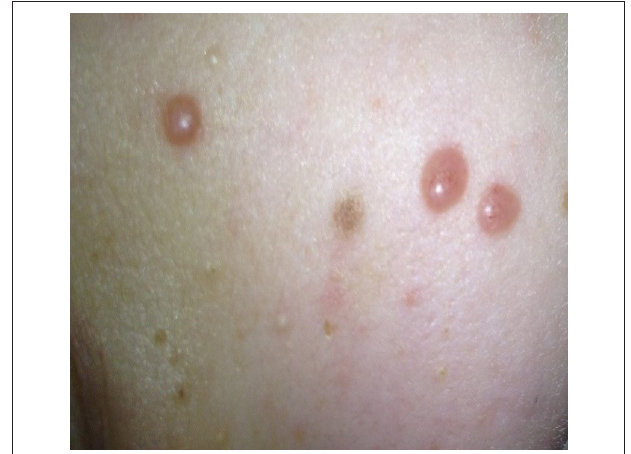
FIGURE 1 | Multiple papulonodular skin lesions with predilection for